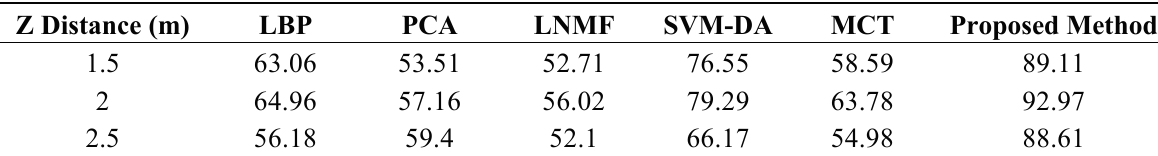
Table 7. The comparisons of face recognition accuracy (GAR) of our method to previous ones according to different Z distances (unit: %).